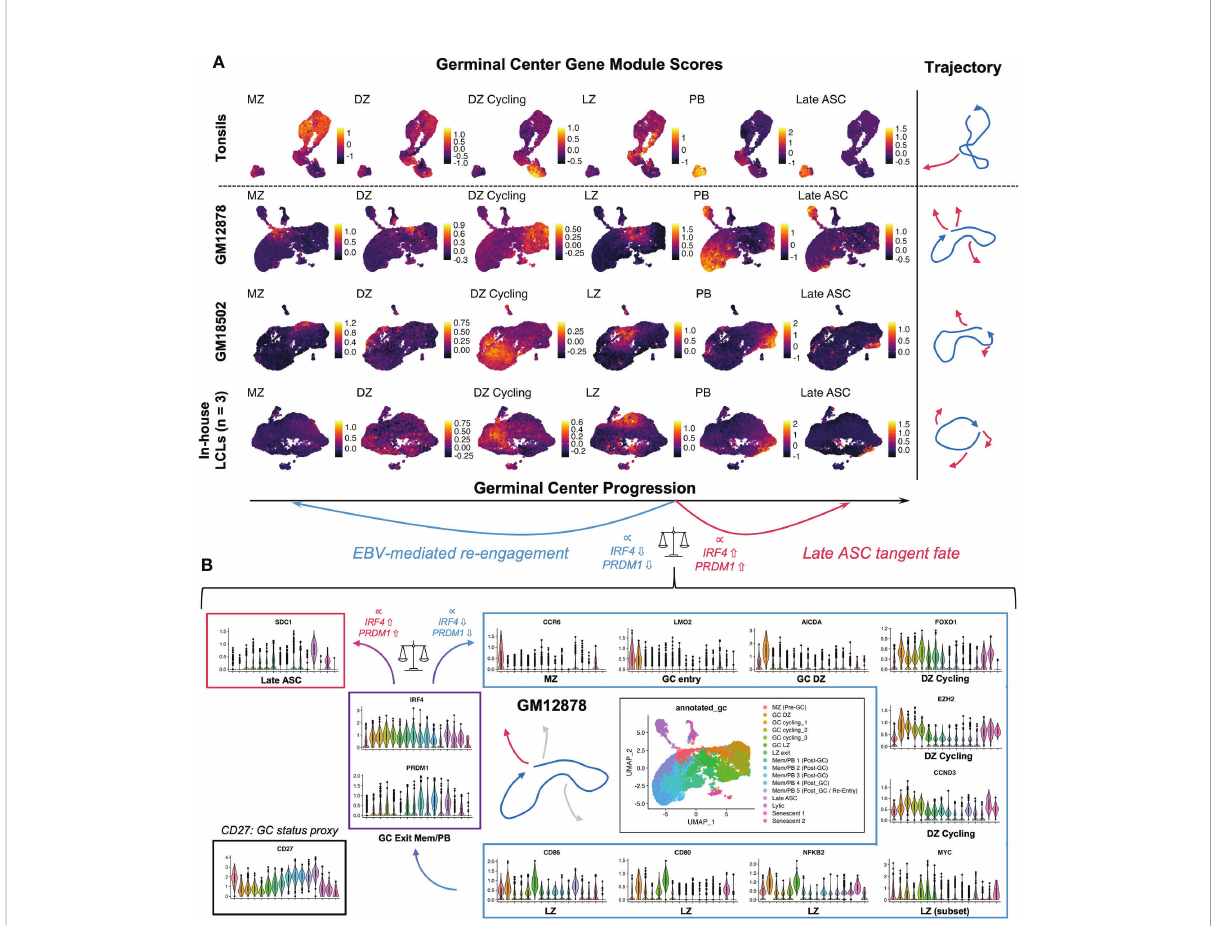
FIGURE 4 LCL subsets exhibit co-expression of genes associated with distinct GC phenotypes. (A) Gene module scores for mantle zone (MZ), dark zone (DZ), DZ cycling, light zone (LZ), plasmablast (PB), and antibody-secreting cell (ASC) states across tonsils and LCLs. Trajectories depict the path starting at the MZ phenotype and progressing through DZ, DZ cycling, LZ, post GC PB, and Late ASC. Blue trajectories depict the core GC and red trajectories represent exits from this dynamic. [MZ module = CCR6, CD22, CD69, FCRL4, FCRL5, BANK1, MARCH1 ; DZ module = AICDA, FOXO1, CXCR4, AURKC, IL2RB ; DZ cycling module = TCF3, EZH2, CCND3, E2F2, TP53, PLK4, BRCA1 ; LZ module = NFKB1, NFKB2, CD80, CD83, CD86, BCL2A1, EBI3, CD40, CR2, MIR155HG, ACKR3, MYO1C, MYC ; PB module = PRDM1, XBP1, MZB1, TNFRSF17, CD27, CD38 ; Late ASC = SDC1 ] (B) Detailed example of a GC-like cell paths in GM12878. Violin plots depicting key gene expression are presented to highlight the core GC dynamic (blue trajectory and box) as well as terminal differentiation to Late ASCs (red trajectory and box). The bifurcation point